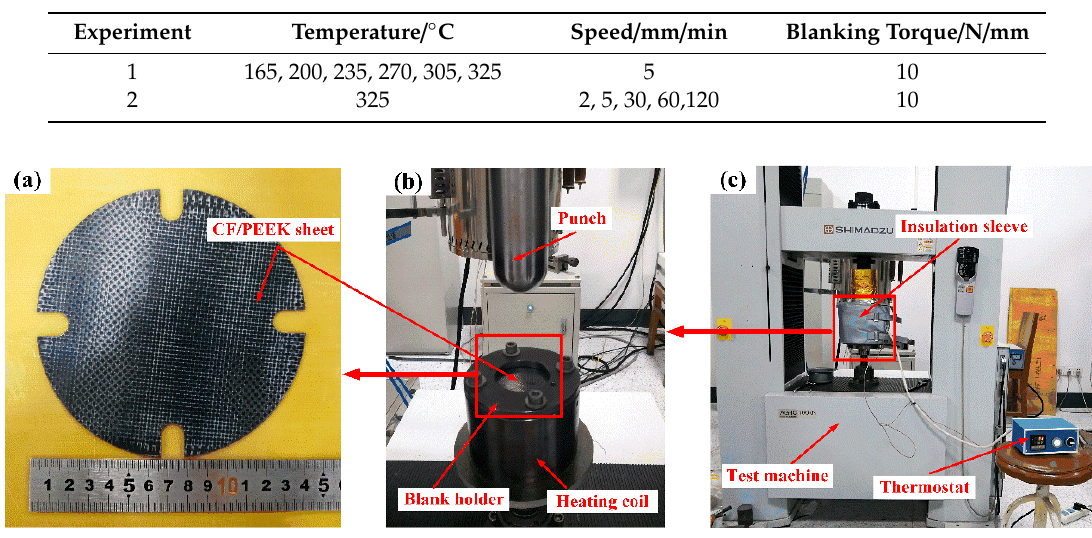
Figure 4. Representation of the Erichsen test at elevated temperatures: ( a ) Specimens; ( b ) test mold; and ( c ) test equipment.